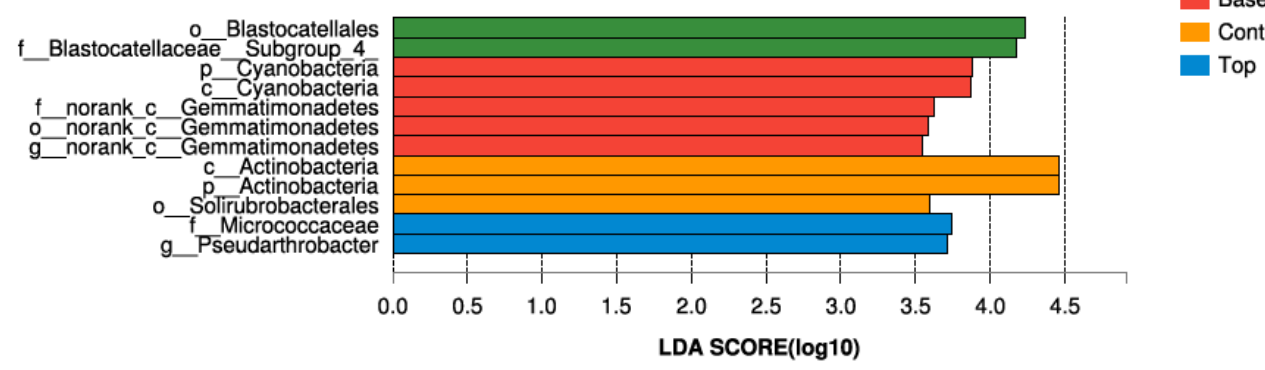
Figure 3. LEfSe bar chart of bacterial clades in different treatments. BT, combined base fertilizer and topdressing fertilizer; Top, topdressing fertilizer; Base, base fertilizer; Control, no fertilizer.